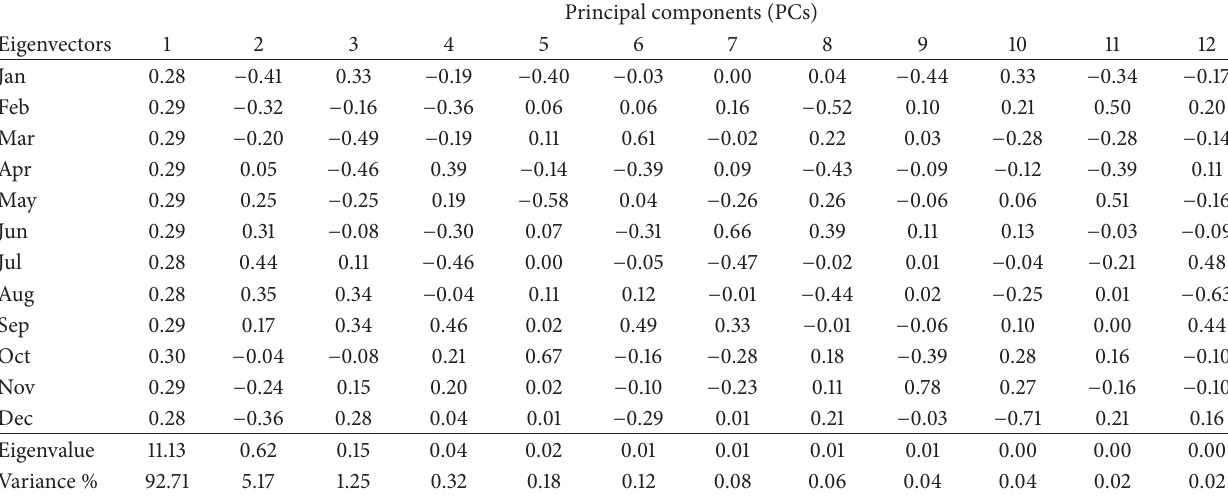
Table 2: Eigenvalues and eigenvectors for the PCs of the mean monthly ET 𝑜 . Principal components